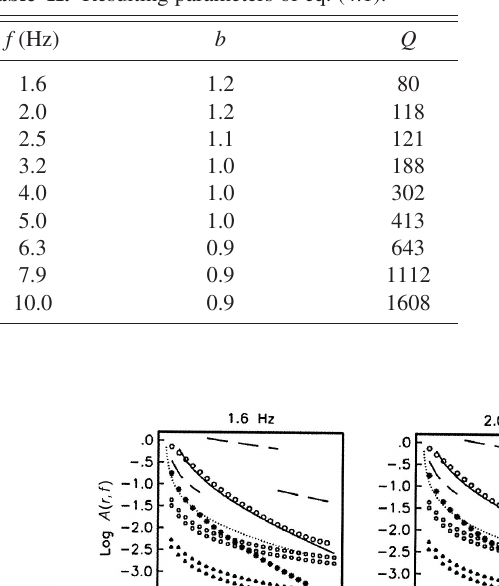
Table II. Resulting parameters of eq.